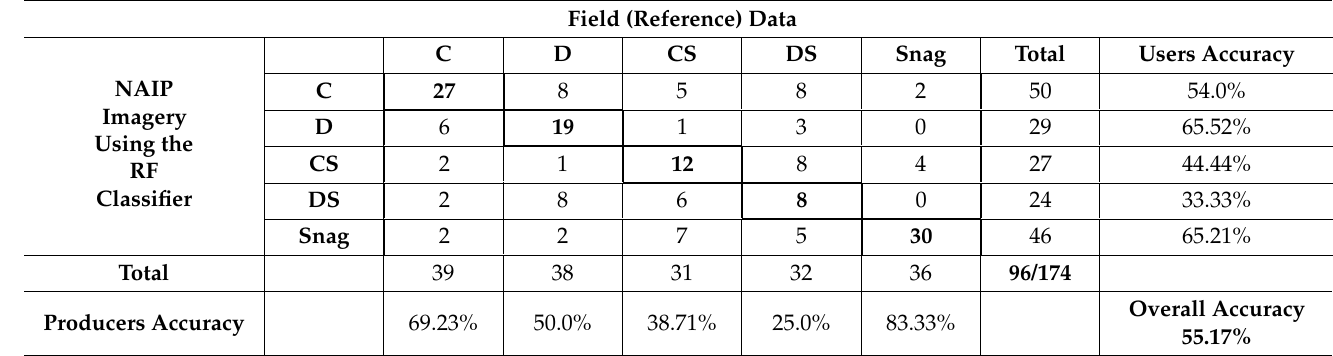
Table 3. Forest health thematic map accuracy assessment error matrix produced using the NAIP imagery, random forest (RF) supervised classification algorithm, and feature reduction digital classification method. The classes represented in this error matrix include: coniferous (C), deciduous (D), coniferous stressed (CS), deciduous stressed (DS), and snag (dead/degraded).